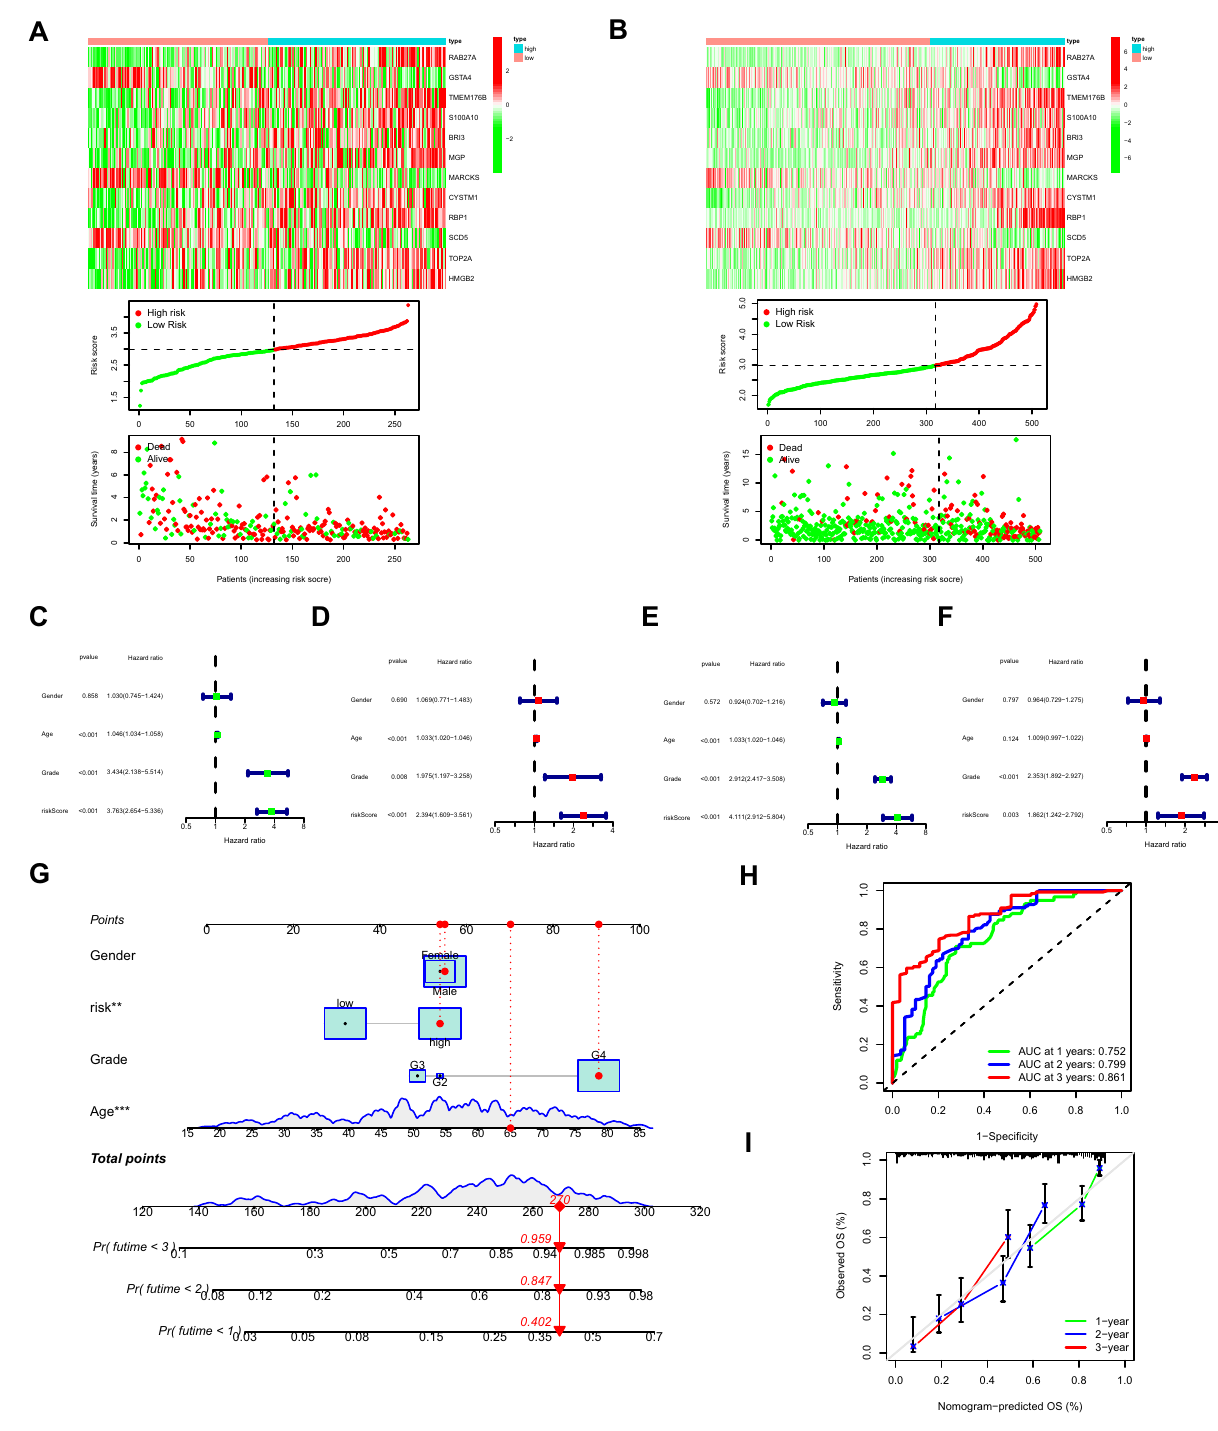
Figure 6. Construction and evaluation of the nomogram. ( A ) Heatmap showing the expression patterns of prognostic genes in the model, the curve of risk scores and scatter plot of survival states in the training cohort. ( B ) Verification of the above results using the validation cohort. ( C ) Forest plot showing the results of univariate cox regression analysis of the risk score and clinicopathological features in the training cohort. ( D ) Forest plot showing the results of multivariate cox regression analysis of the risk score and clinicopathological features in the training cohort. ( E , F ) Verification of the above results using the validation cohort. ( G ) Nomogram integrating risk, age, gender, grade as variables with predictions of survival at 1, 2, and 3 years using the training cohort. ( H ) The ROC curves of the nomogram for predicting 1-year, 2-year and 3-year overall survival in the training cohort. ( I ) The calibration curves evaluating the